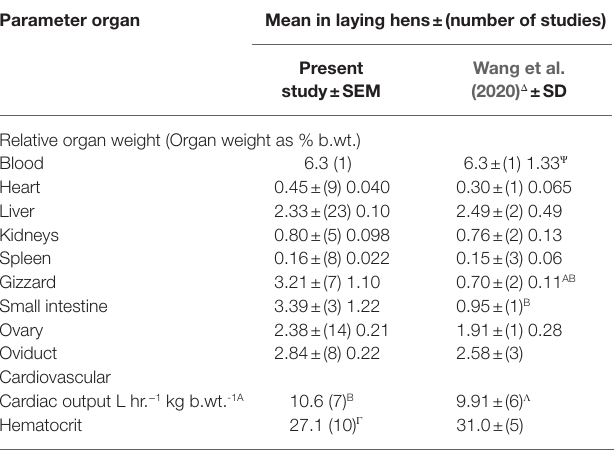
Blood flow mL min -1 Δ , Φ , Ω